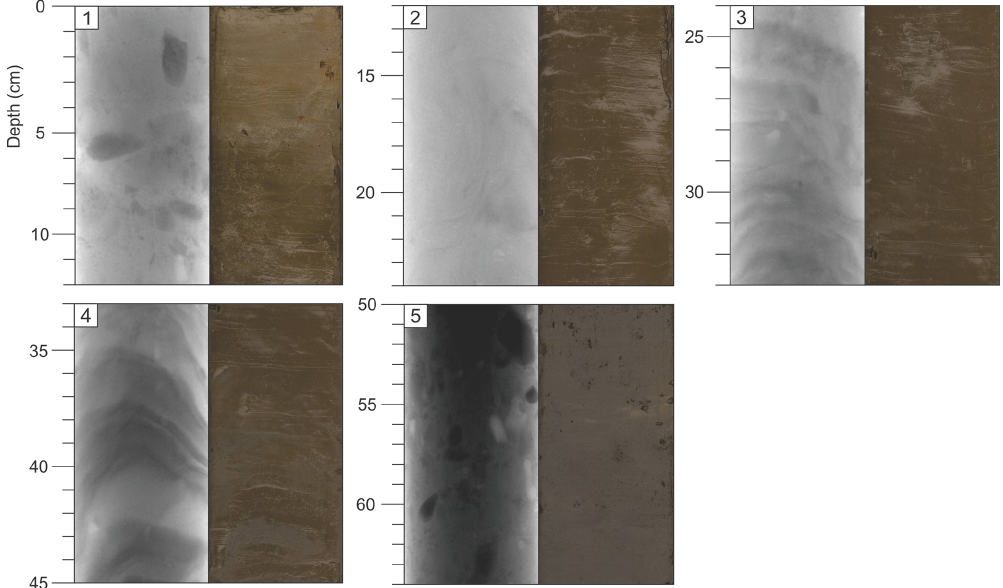
Figure 3. X-radiographs with associated photographs of representative lithofacies in this study, all from core HH17-1326. (1) Massive mud with ice-rafted debris (IRD) ( Fm(d) ). (2) Massive mud ( Fm ). (3) Laminated mud with occasional IRD ( Fl(d) ). (4) Laminated mud ( Fl ). (5) Diamicton ( Dmm ). The darker grey tones on the X-radiographs reflect higher density, whereas brighter grey tones reflect lower